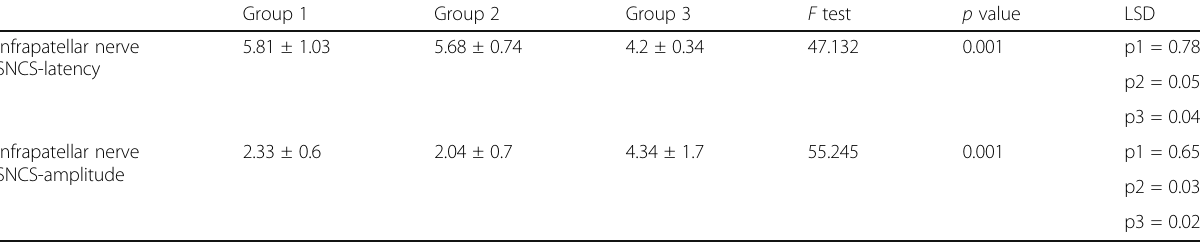
Table 5 Sensory nerve conductive study of infrapatellar nerve among patients of the three studied groups in the affected side